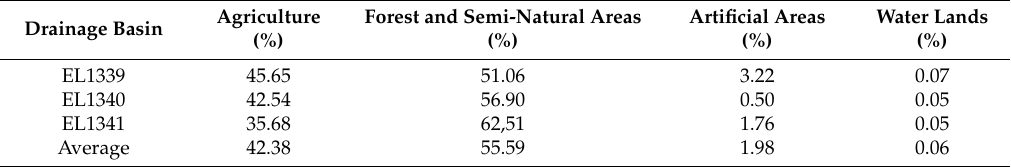
Figure 6. Ecosystems in Crete (modified from [51]) . Small figure illustrates the three drainage basins of Crete (north (EL1339) (purple), south (EL1340) (green), and east (EL1341) (blue) (modified from [15]) . Table 2. Drainage basin coverage of Crete by di ff erent land uses. Source: Table 2. Drainage basin coverage of Crete by different land uses. Source: [15] ).